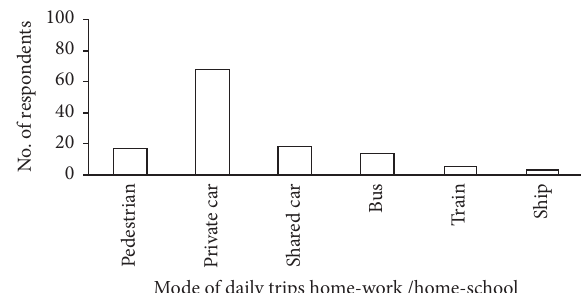
Figure 5: Modal split among existing transport modes.